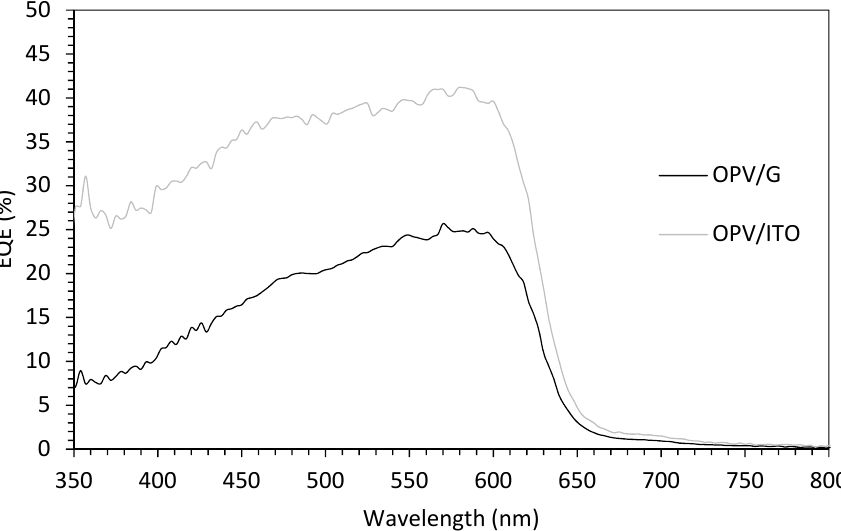
Figure 5. EQE spectra of OPV cells using graphene and ITO as a transparent electrode. This is for the best of five devices of OPV/G comparing with control standard device of OPV/ITO.